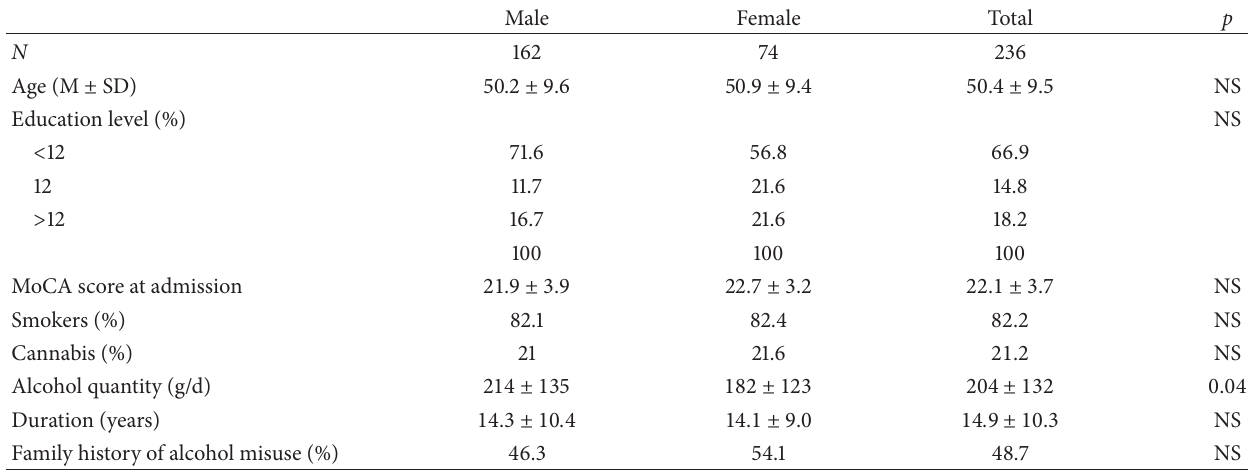
Table 1: Main characteristics of the patients